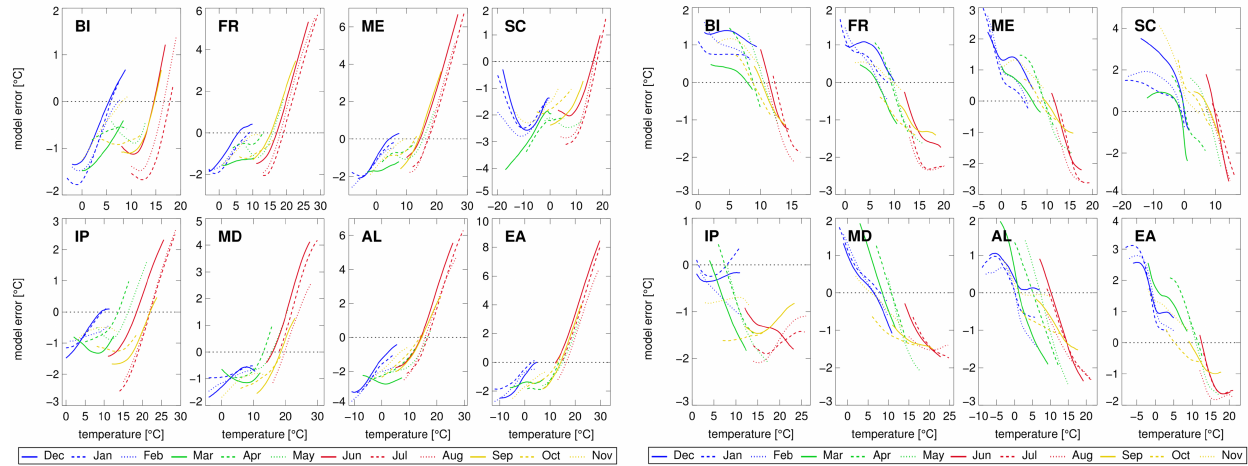
Figure 4. Temperature error characteristics (model minus observation) of the HC (left panels) and SMHI (right panels) RCMs in eight subregions of Europe (sub-panels) and each month of the